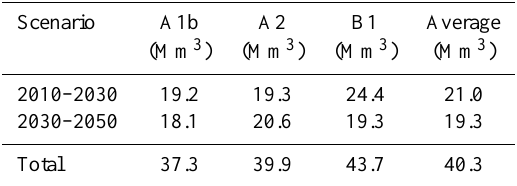
Table 2. Projected total recharged water (millionm 3 ) under A1b, A2, and B1 scenarios for near and far